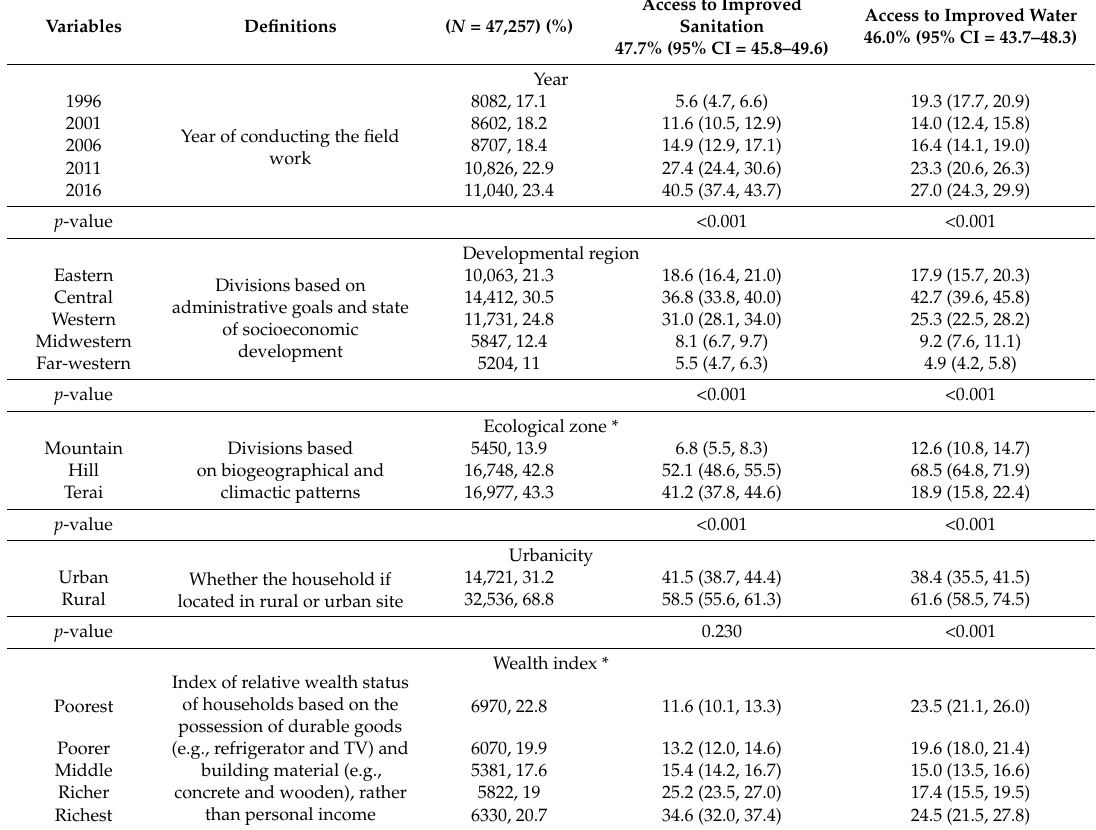
Table 2. Geographic and sociodemographic profile of the households and